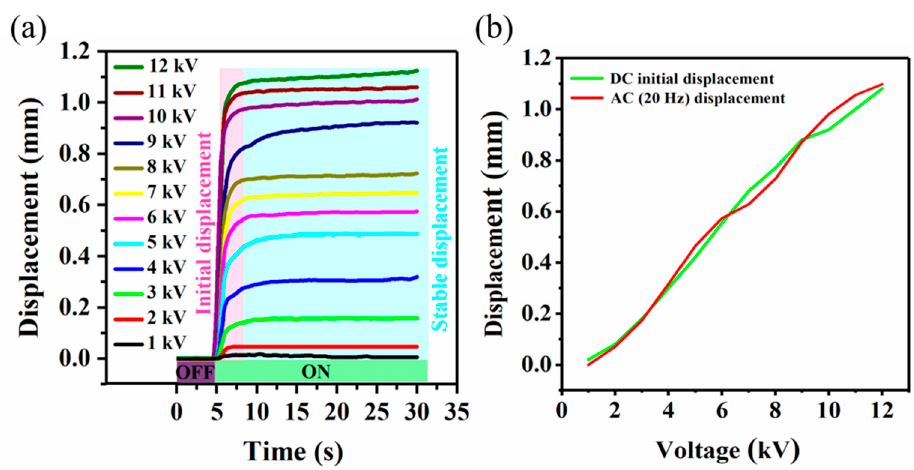
Figure 7. ( a ) Output displacement of the actuator under 20 Hz-square wave voltages over time. ( b ) Dependence of the stable output displacement of the actuator on DC and AC